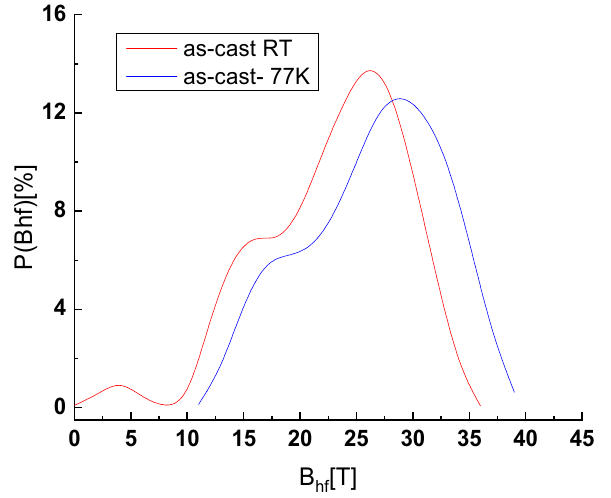
Figure 3. 300K and 77K Mössbauer HF distribution of as-cast Fe 65 Pt 15 Zr 3 B 17 sample.